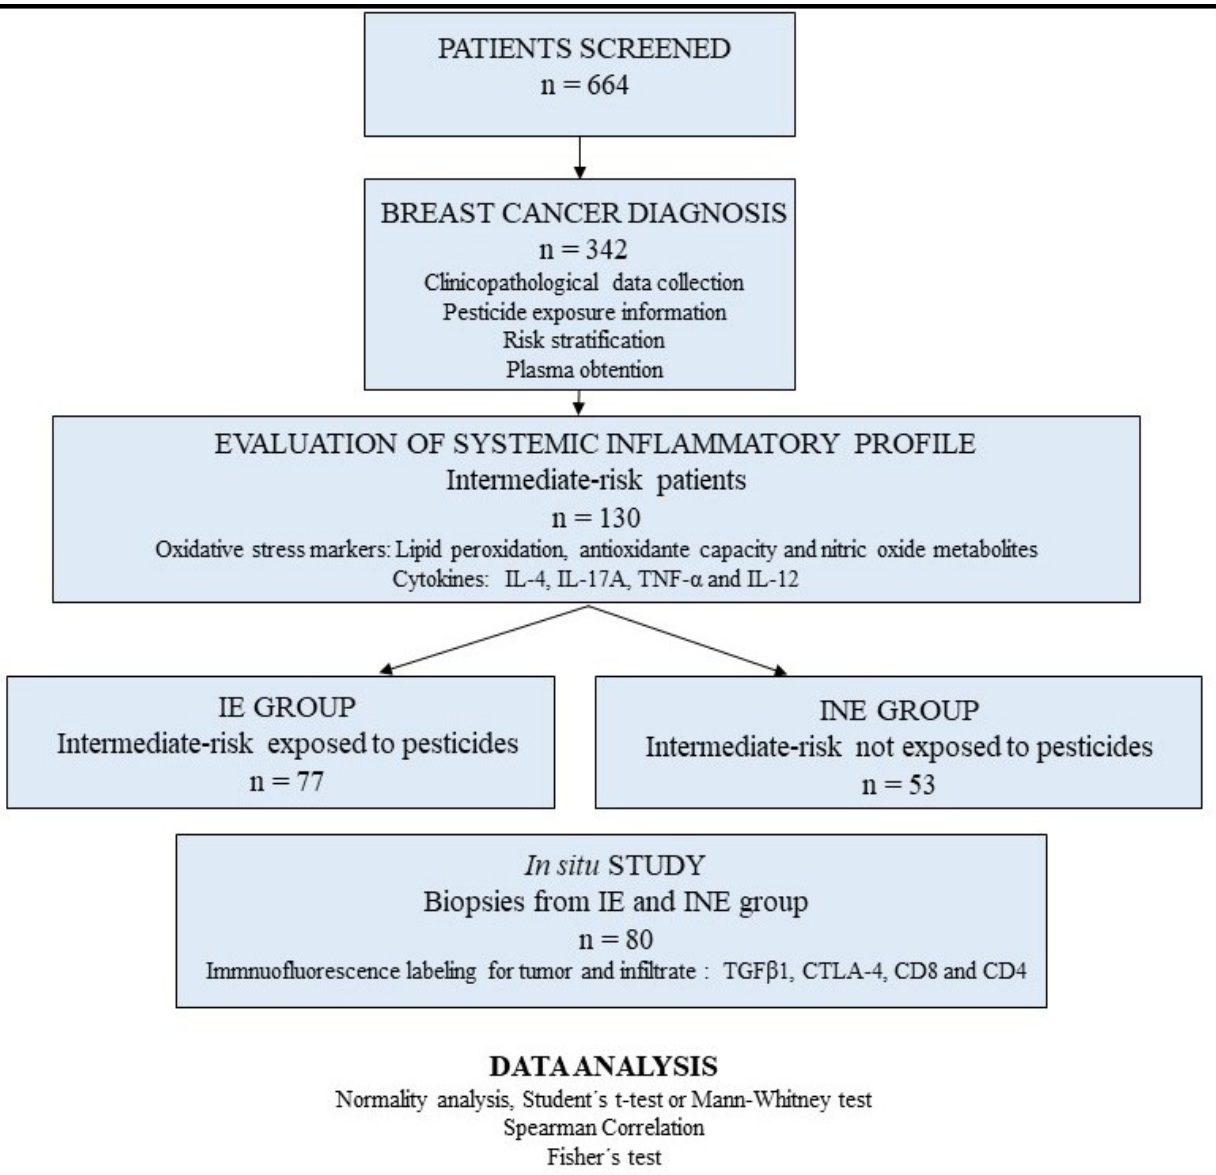
Figure 1. Study design. Six hundred sixty-four patients were screened. Three hundred forty-two were diagnosed with breast cancer. Based on risk stratification and pesticide exposure data, 130 patients were included and categorized into intermediate-risk exposed to pesticides ( n = 77) and intermediate-risk unexposed to pesticides ( n = 53). The in situ analysis was randomly selected by lot ( n = 80).